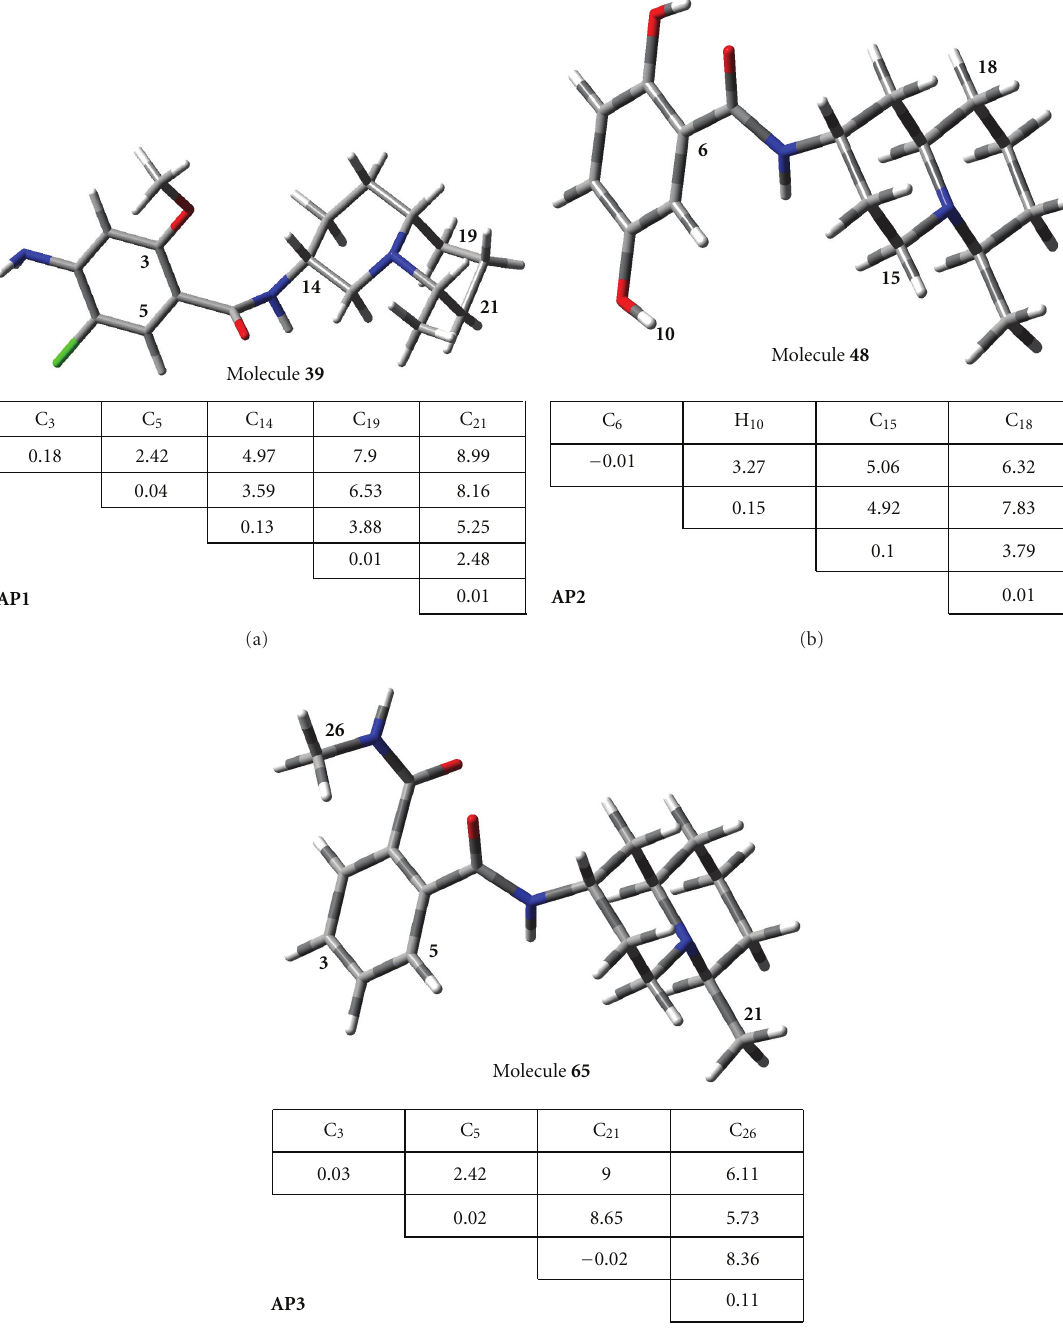
Figure 5: ETSC of the antipharmacophores: AP1 , AP2, and AP3 found relative to active molecule 39 , 48, and 65